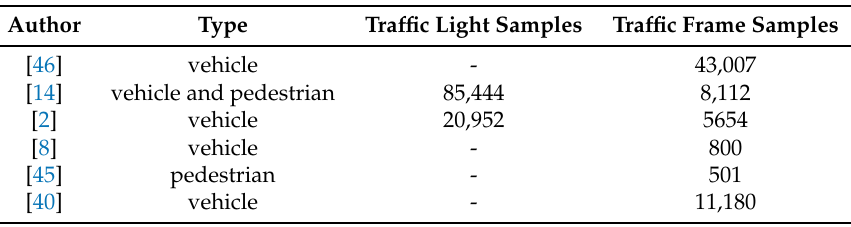
Table 2. Public traffic light